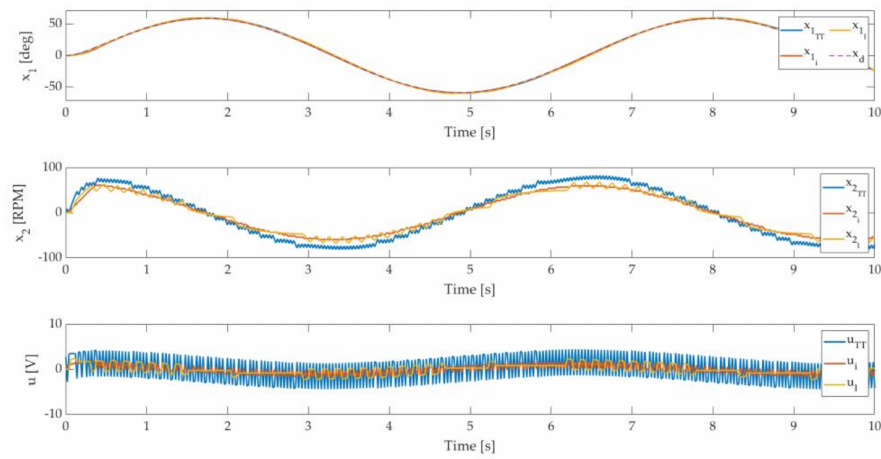
Figure 6. Tracking capability comparison of TT and ET techniques to the periodic signal x d .